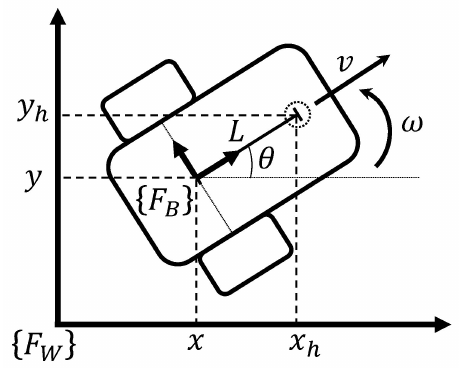
Figure 1. Differential drive robot